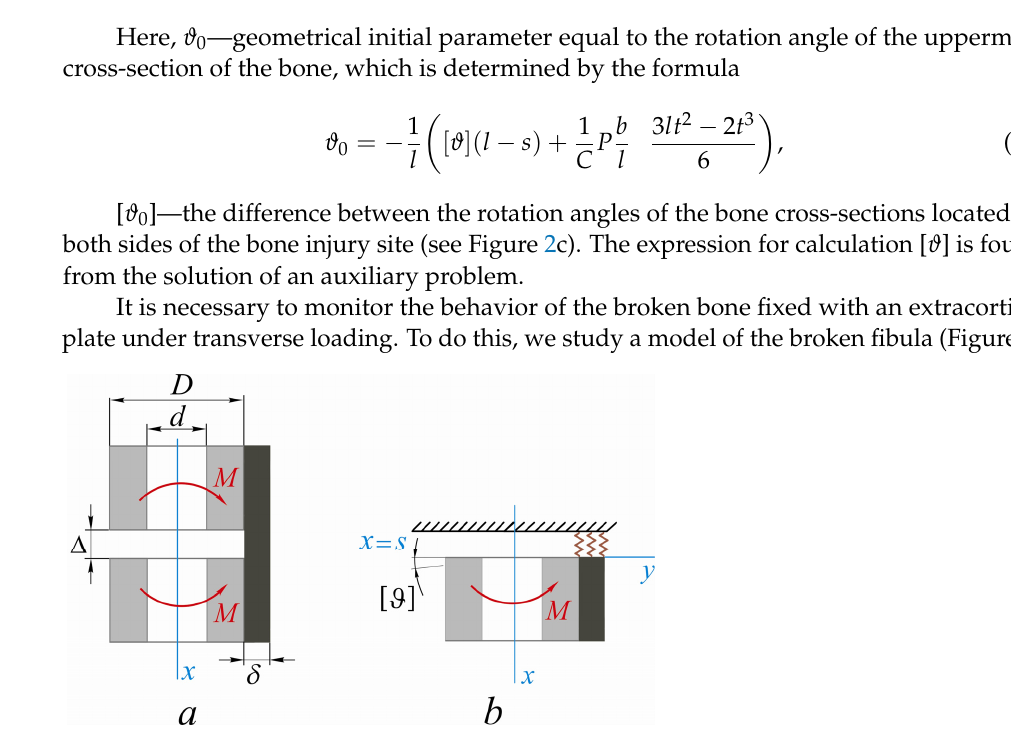
Figure 4. A model of the broken fibula fixed with an extracortical plate ( a ) and the calculation scheme ( b